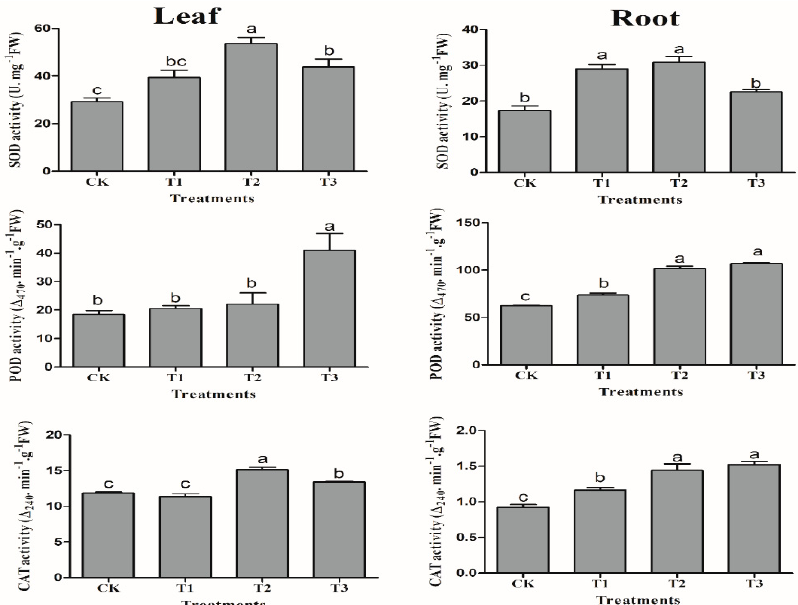
Figure 5. Effect of exogenous ALA application on antioxidant enzyme activities under low-temperature and weak-light stress in cucumber seedlings. Data are the means of four replicates; error bars indicate the standard deviation. Treatments with the same lower-case letter are not significantly different (least significant difference test, p = 0.05). SOD, superoxide dismutase; POD, peroxidase; CAT, catalase.